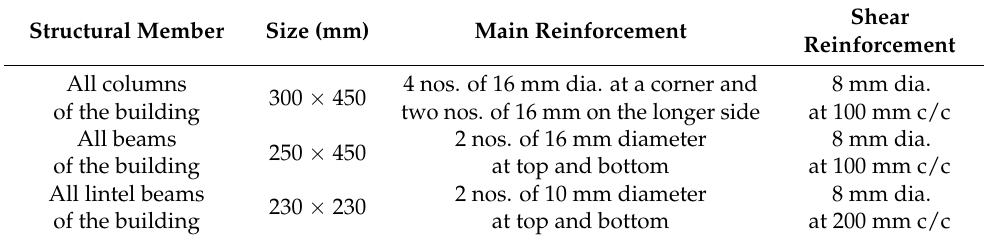
Table 3. Dimensions and detailing of the structural members.